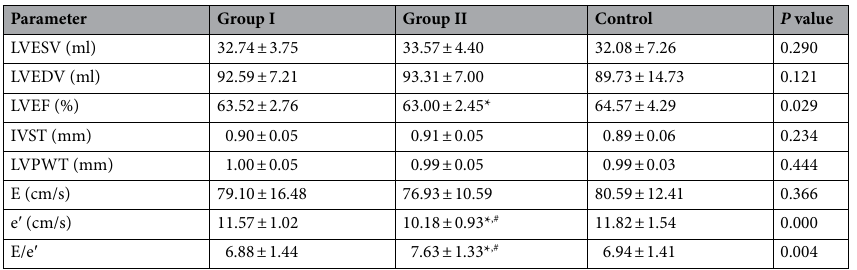
Table 2. Conventional echocardiographic parameters. Data are presented as mean ± standard deviation. LVESV, left ventricular end-systolic volume; LVEDV, left ventricular end-diastolic volume; LVEF, left ventricular ejection fraction; IVST, interventricular septal thickness; LVPWT, left ventricular posterior wall thickness. *Compared with control group, P < 0.05. # Compared with group I, P < 0.05.